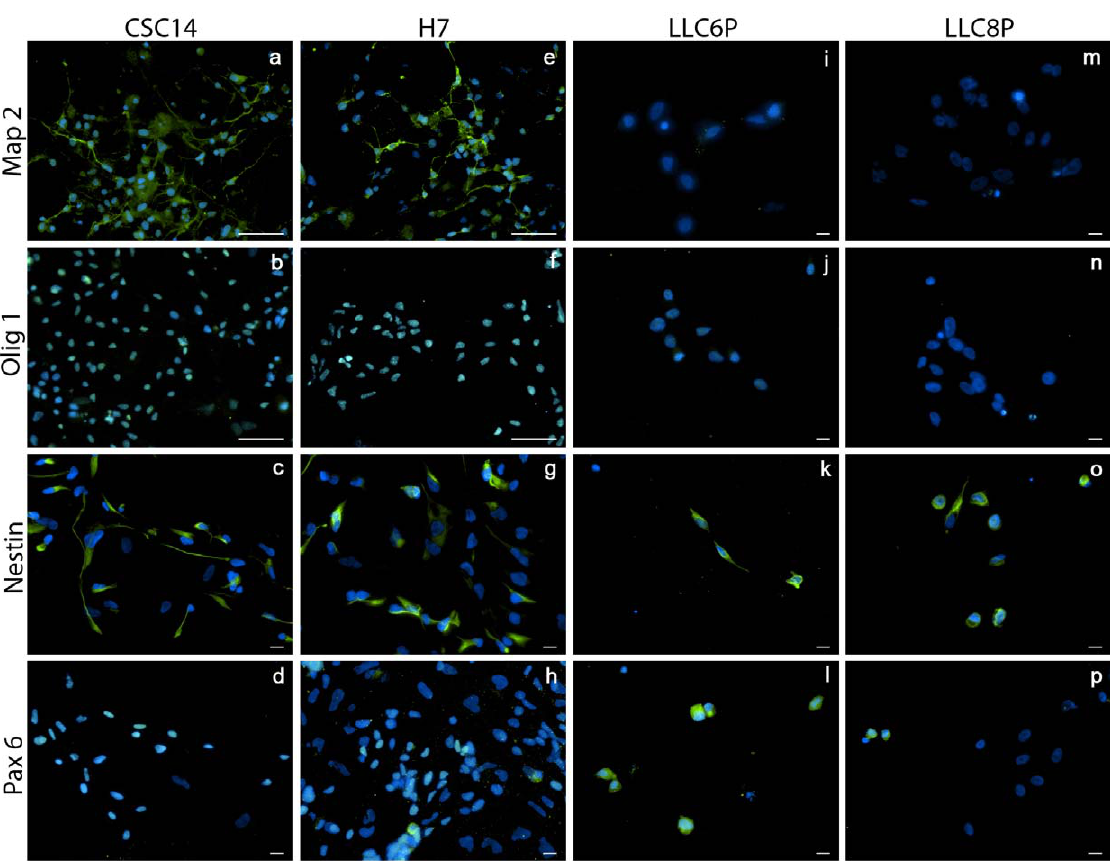
Figure 4. Immunocytochemical profile following NPC differentiation. Parthenote-derived lines displayed impaired neural maturation, but expressed immature markers normally. CSC14 (a–d), H7 (e–h), LLC6P (i–l) and LLC8P (m–p). Map2 (a, e, i and m), Olig1 (b, f, j and n), Nestin (c, g, k and o) and Pax6 (d, h, l and p). Scale bars represent 50 m m (a, b, e and f) and 10 m m (c, d, and g–p).